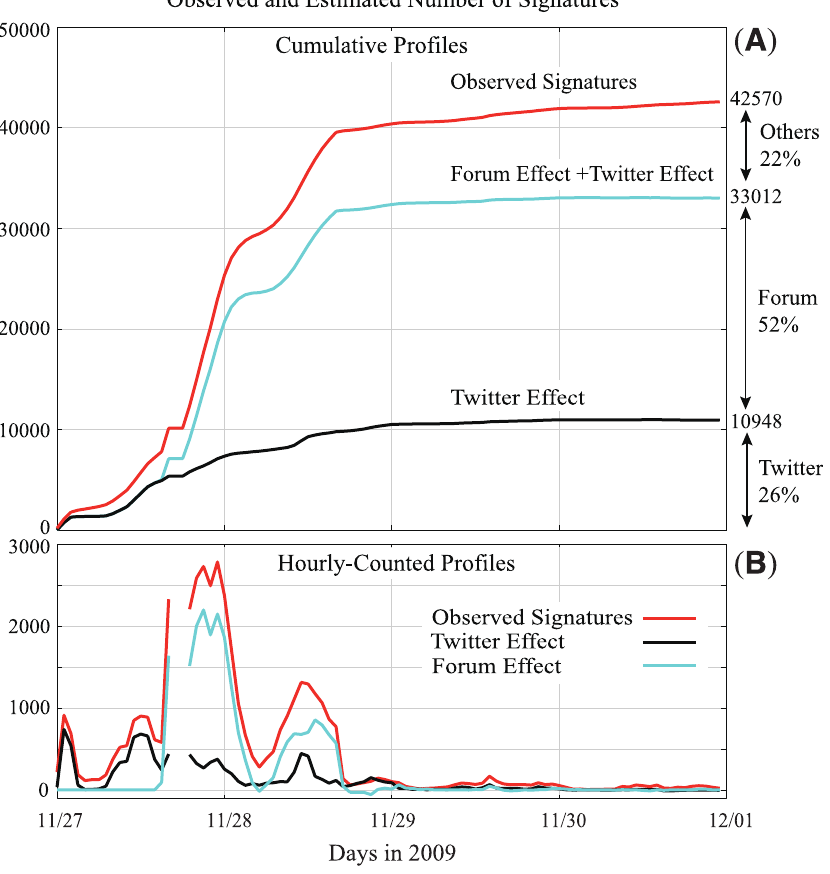
Figure 3. The observed signatures and estimated contributions from the two social media. (A) the cumulative and (B) the hourly-counted profiles of the observed signatures and the estimated Twitter and Forum